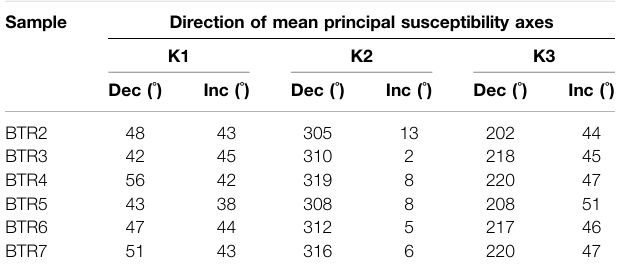
TABLE2| Directionsofmeanprincipalsusceptibilityaxesofthesamples(BTR2to BTR7). Sample